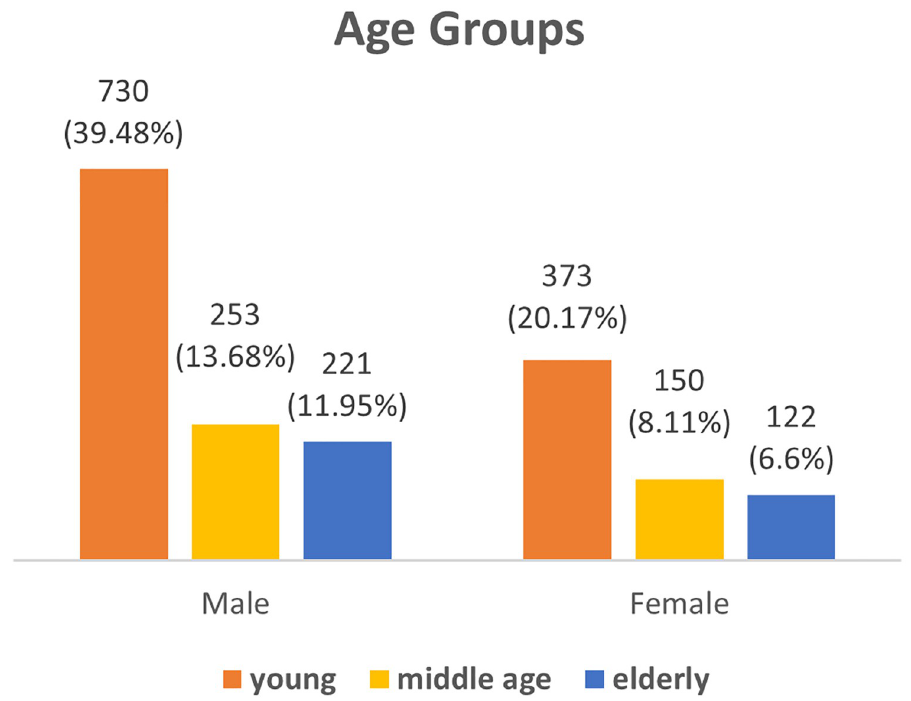
Fig 1. Distribution of the age